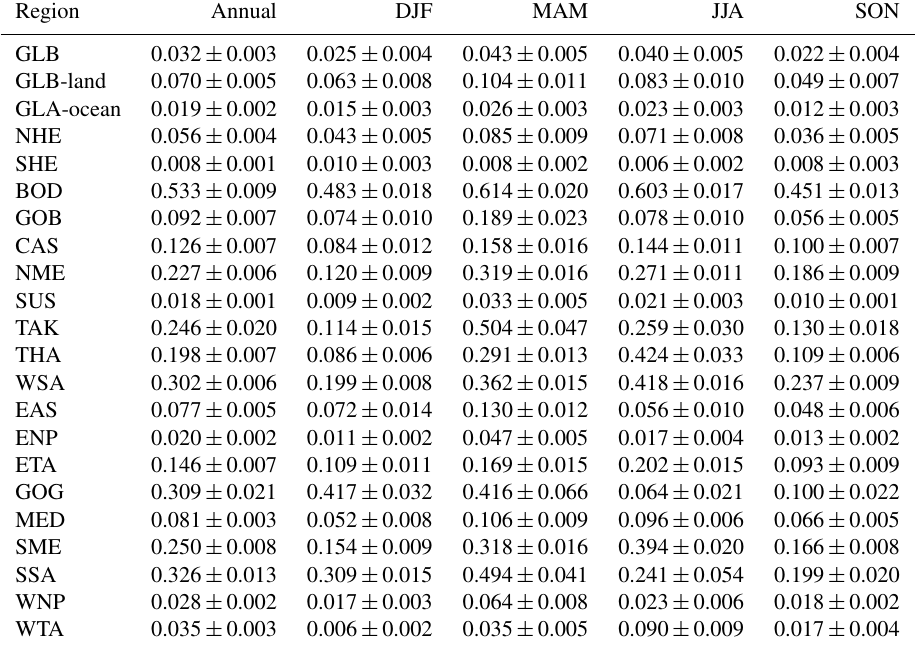
Table 1. Annual and seasonal DOD averages, representative for the period 2003–2017, along with the associated uncertainty. The first three rows refer to the whole globe (GLB), the global land (GLB-land) and global ocean (GLB-ocean). In the fourth and fifth line the results for Northern Hemisphere (NHE) and Southern Hemisphere (SHE) DODs are given, whereas in the remaining 17 entries the corresponding results for selected subregions (denoted with colored rectangles in Fig. 7 in Gkikas et al., 2021) are